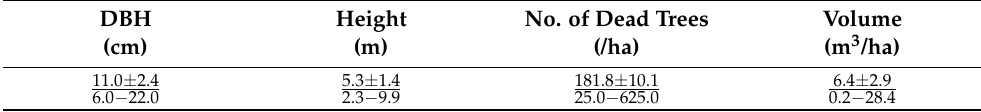
Table 1. Summary of observed dead trees statistics for Pinus densiflora stands in South